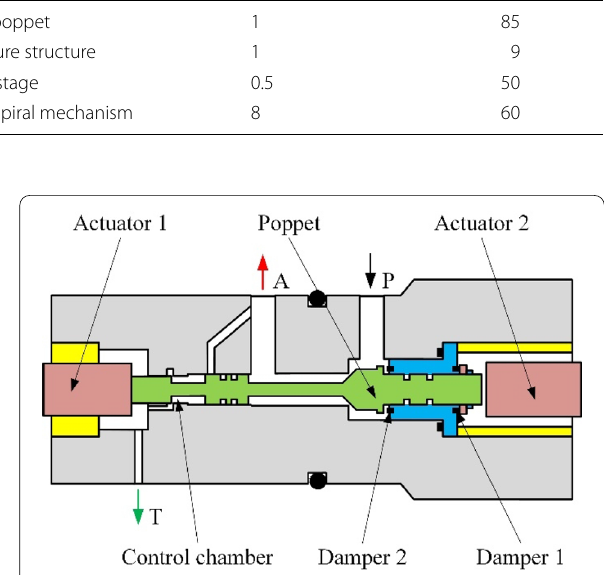
Figure 17 Poppet valve with two piezoelectric actuators provided by Jiang et al.